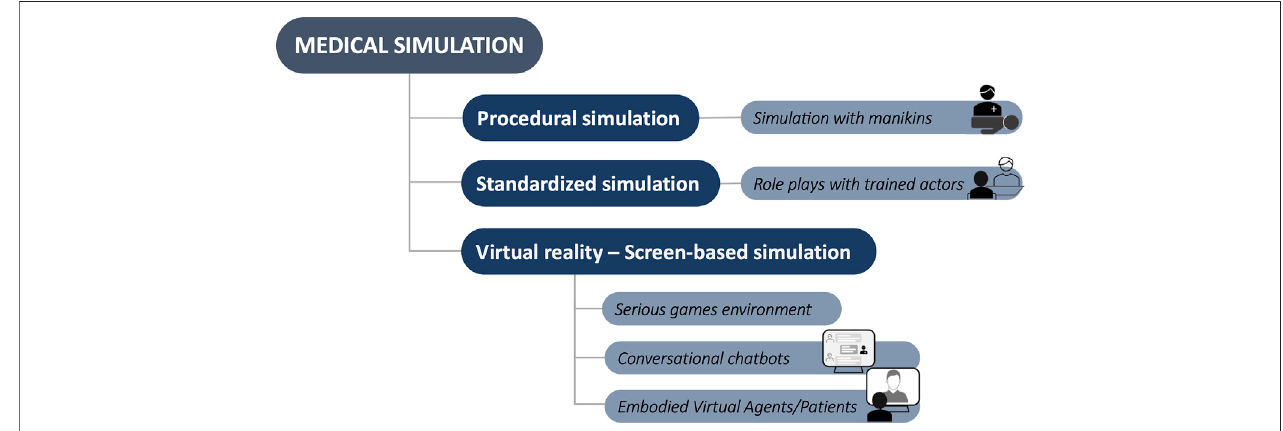
FIGURE 1 | Simple classi fi cation of healthcare simulations. Procedural simulation is based on manikins that represent a full or partial human body; Standardized simulation isbasedonrole-playingwithpatients playedbyactorsinrealclinicalsituationsorthroughvideos; Virtualreality simulationisbasedoncomputertechnologyto create interactive virtual worlds that the user can interact with (e.g., serious games, conversational chatbots or Embodied Virtual Agents.).